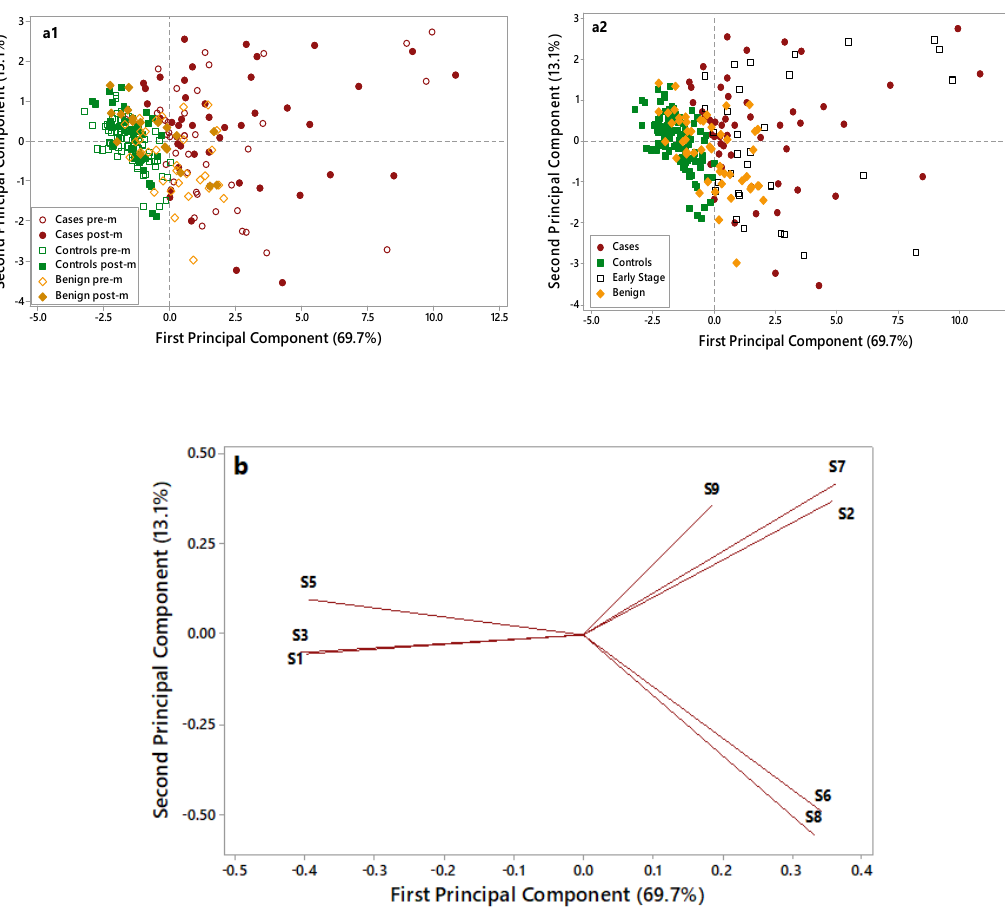
Figure 2. Interval plot of electronic nose data set for the ovarian cancer (OC) cases (red) and controls (green).